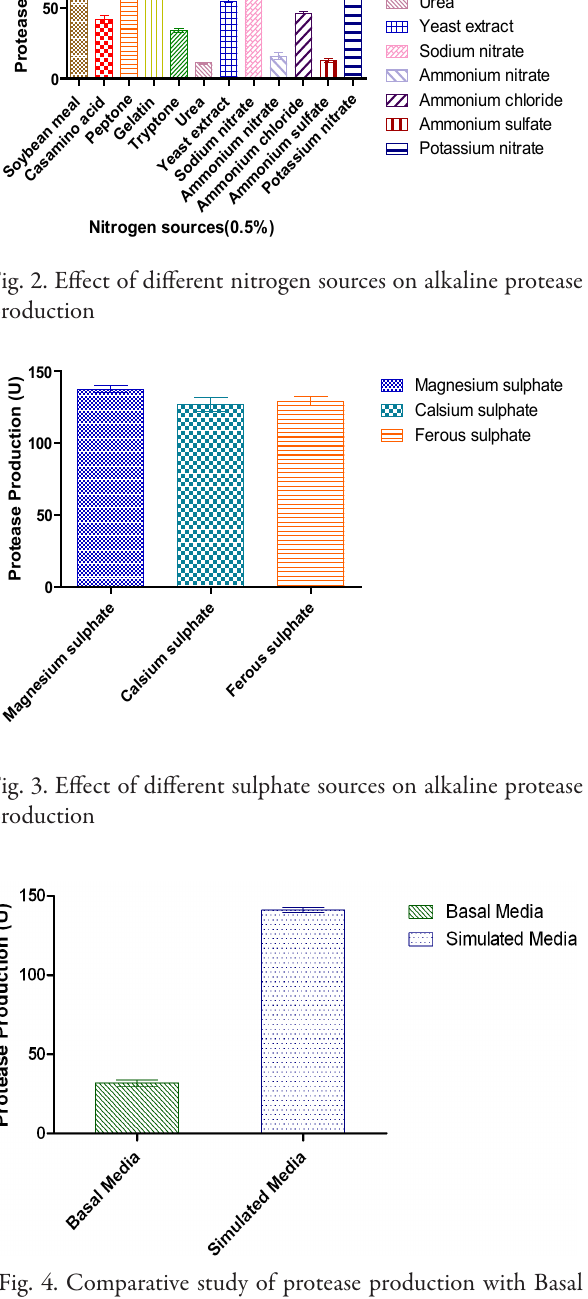
Fig. 4. Comparative study of protease production with Basal and Simulated